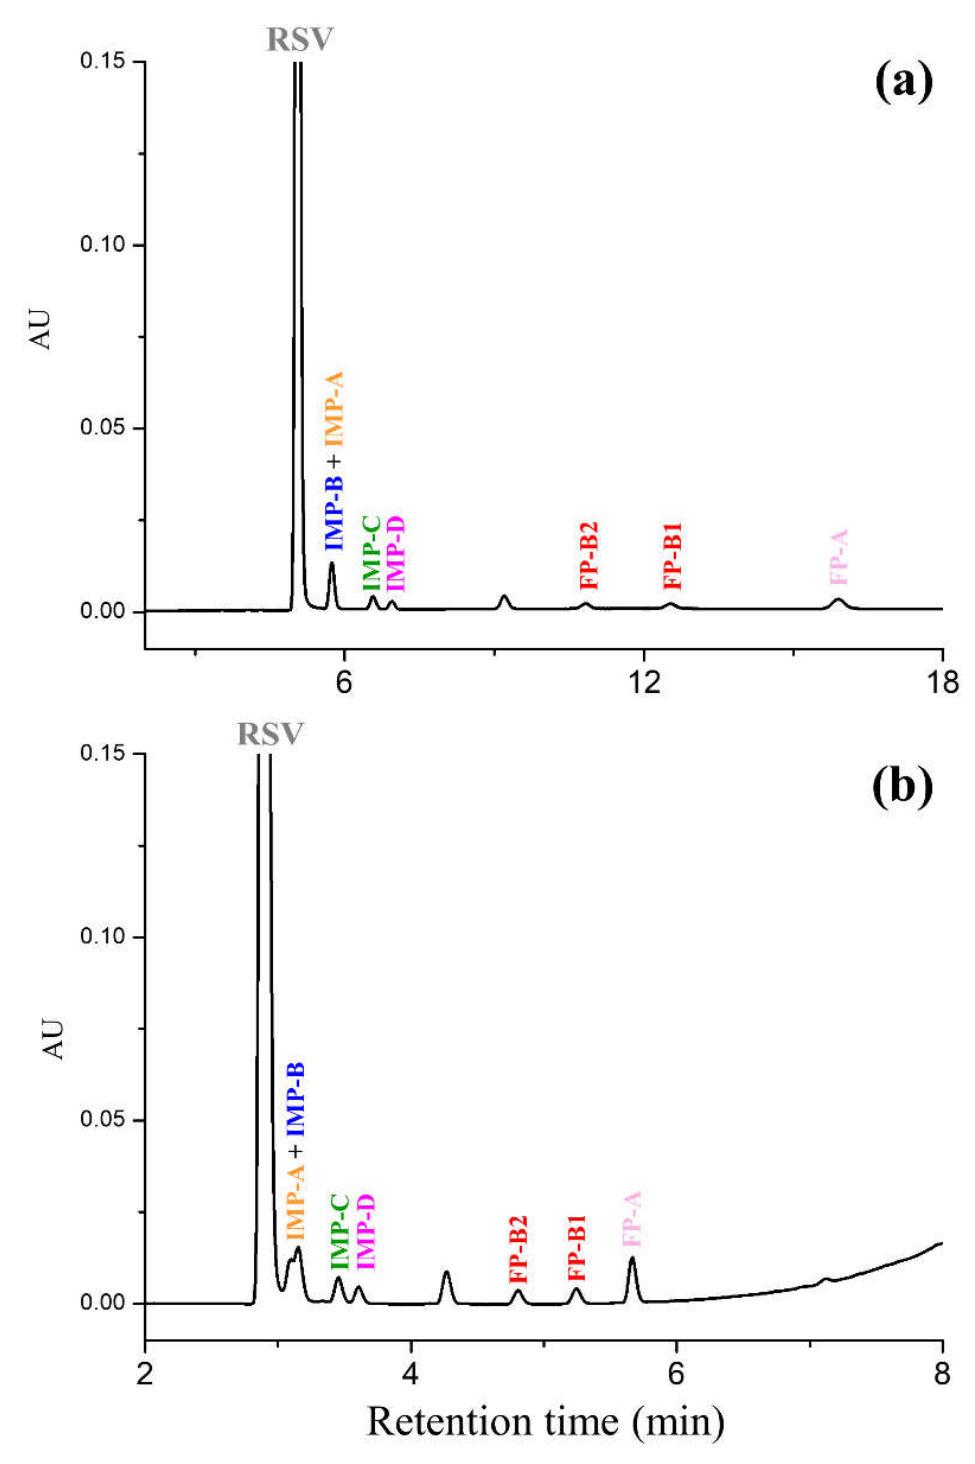
Figure 2. Comparison between UHPLC chromatograms of RSV spiked with impurities on the Acquity BEH C18 (100 mm × 2.1 mm, 1.7 μm) column using ( a ) isocratic and ( b ) gradient elution. Chromatographic conditions: mobile phase, ( a ) MeOH-TFA 0.1% 50:50 ( v / v ), ( b ) solvent A (0.1% TFA ( v / v ) in water) and solvent B (MeOH) [14]; temperature, 40 °C; flow rate, 0.3 mL/min; detection, UV at 240 nm. RSV: rosuvastatin; IMP-A: impurity A; IMP-B: impurity B; IMP-C: impurity C; IMP-